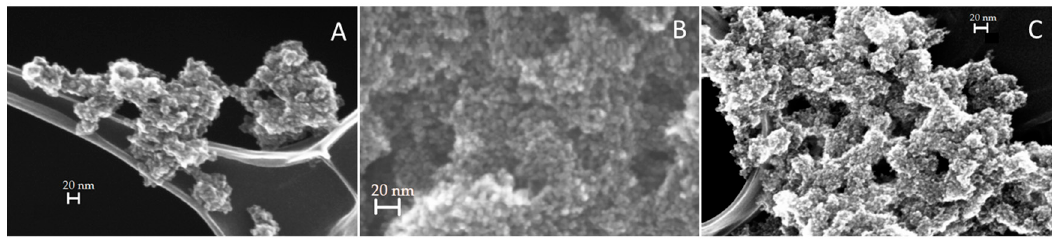
Figure 3. FE-SEM images of the three samples respectively prepared with ( A ) 0.71 mL; ( B ) 0.35 mL and ( C ) 0.18 mL of Fe 3 O 4 NPs.